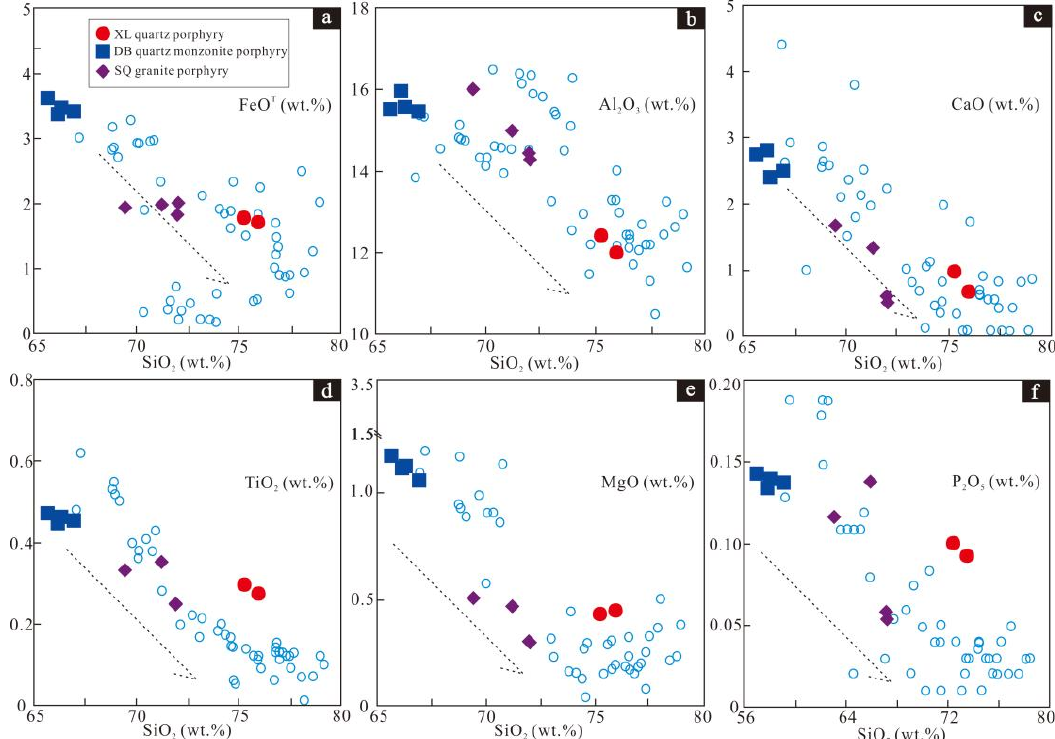
Figure 9. Harker diagrams showing content variation of major elements (modified after Wei et al. [18] and references therein). ( a ) FeO T versus SiO 2 diagram; ( b ) Al 2 O 3 versus SiO 2 diagram; ( c ) CaO versus SiO 2 diagram; ( d ) TiO 2 versus SiO 2 diagram; ( e ) MgO versus SiO 2 diagram; ( f ) P 2 O 5 versus SiO 2 diagram.